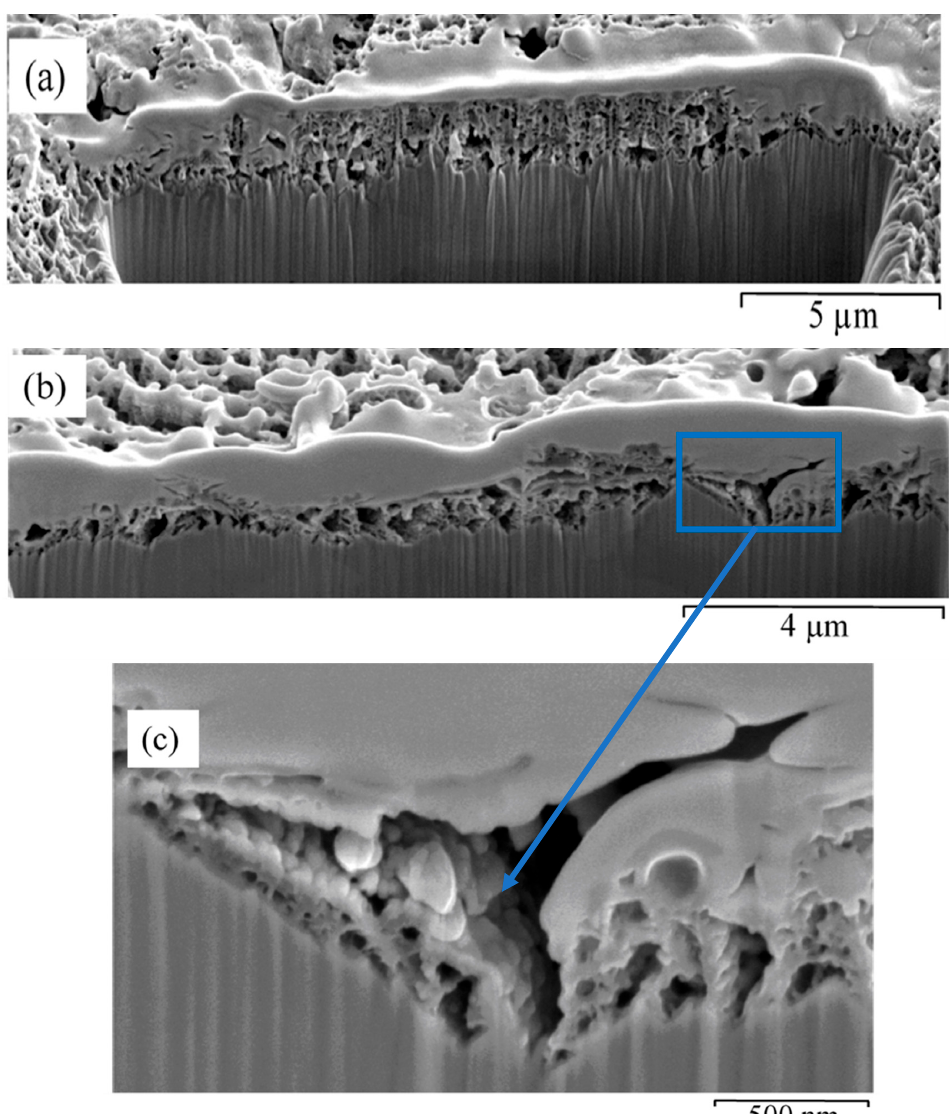
Figure 8. FIB-SEM images of the cross-sections ( a , b ) of biofilm formed two areas of a carbon steel surface by pure culture of IRB in modified Postgate C medium following a 72 h exposure a detailed view ( c ) of the corroded area of the cross-section identified in Figure 8b at higher magnification showing channels that could allow electrolyte